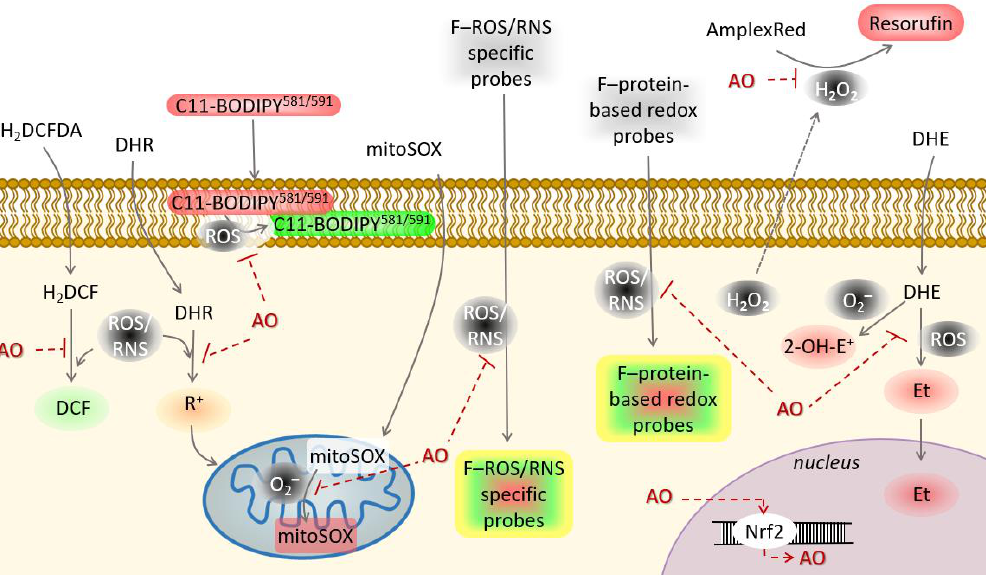
Figure 4. Probes used in HTS assays for the detection of ROS/RNS and lipid peroxidation. Abbreviations: 2-OH-E + — 2-hydroxyethidium; AO — antioxidants; DCF — dichlorofluorescin; DHE—dihydroethidium; DHR—dihydrorhodamine 123; Et — ethidium; F — fluorescent; H 2 DCFDA — 2 ′ ,7 ′ -dichlorodihydrofluorescein diacetate; R + —rhodamine 123.